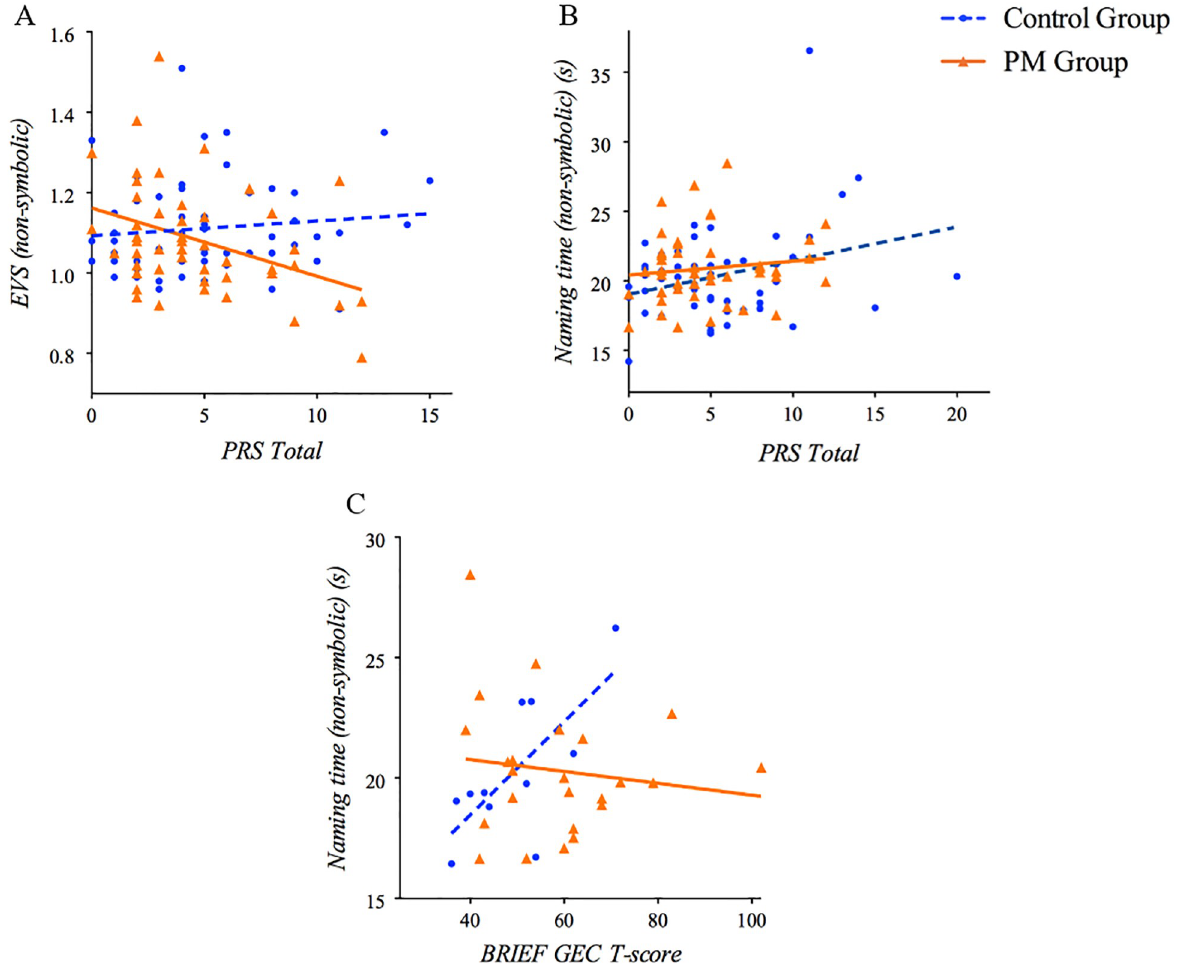
Fig 2. Relationships between RAN performance and gaze with clinical-behavioral correlates. (A) EVS during non-symbolic conditions associated with pragmatic language violations in the PM group ( p < .01), (B) naming time during non-symbolic conditions associated with pragmatic language violations in the control group ( p < .05), (C) naming time during non-symbolic conditions associated with BRIEF GEC T- scores in the control ( p < .05) but not in the PM group.